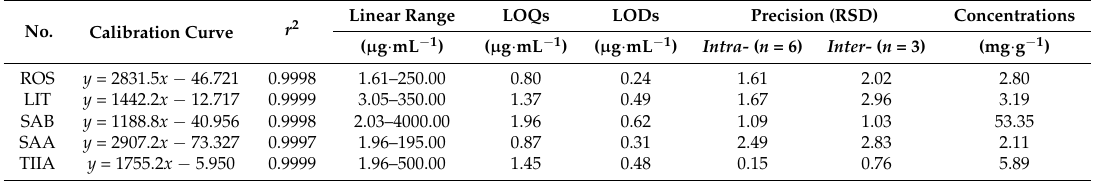
Table 3. Calibration curves, test range, LODs, and precisions for analytes by HPLC.